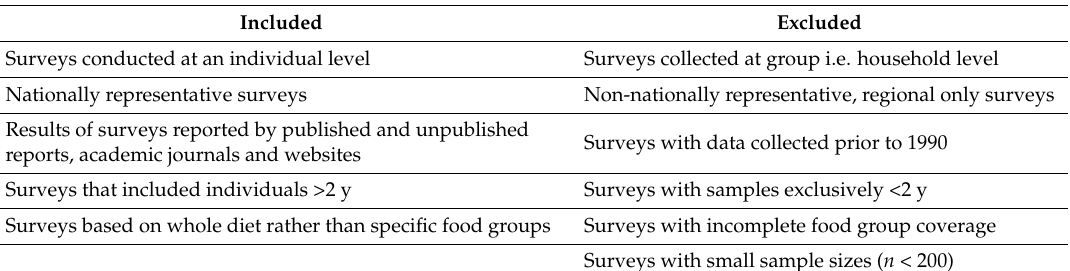
Table 1. Survey inclusion and exclusion criteria.